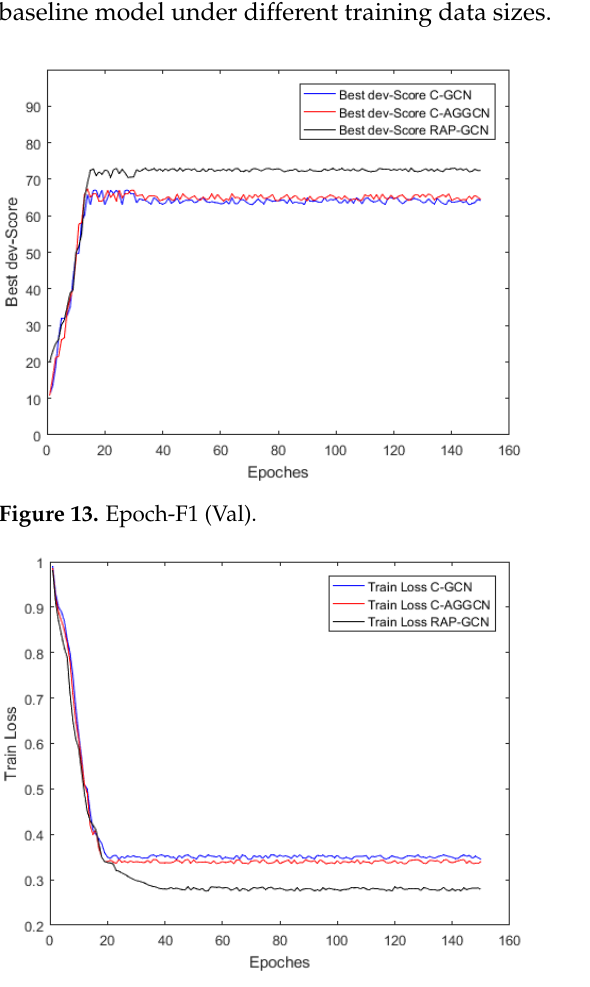
Figure 14. Epoch-loss